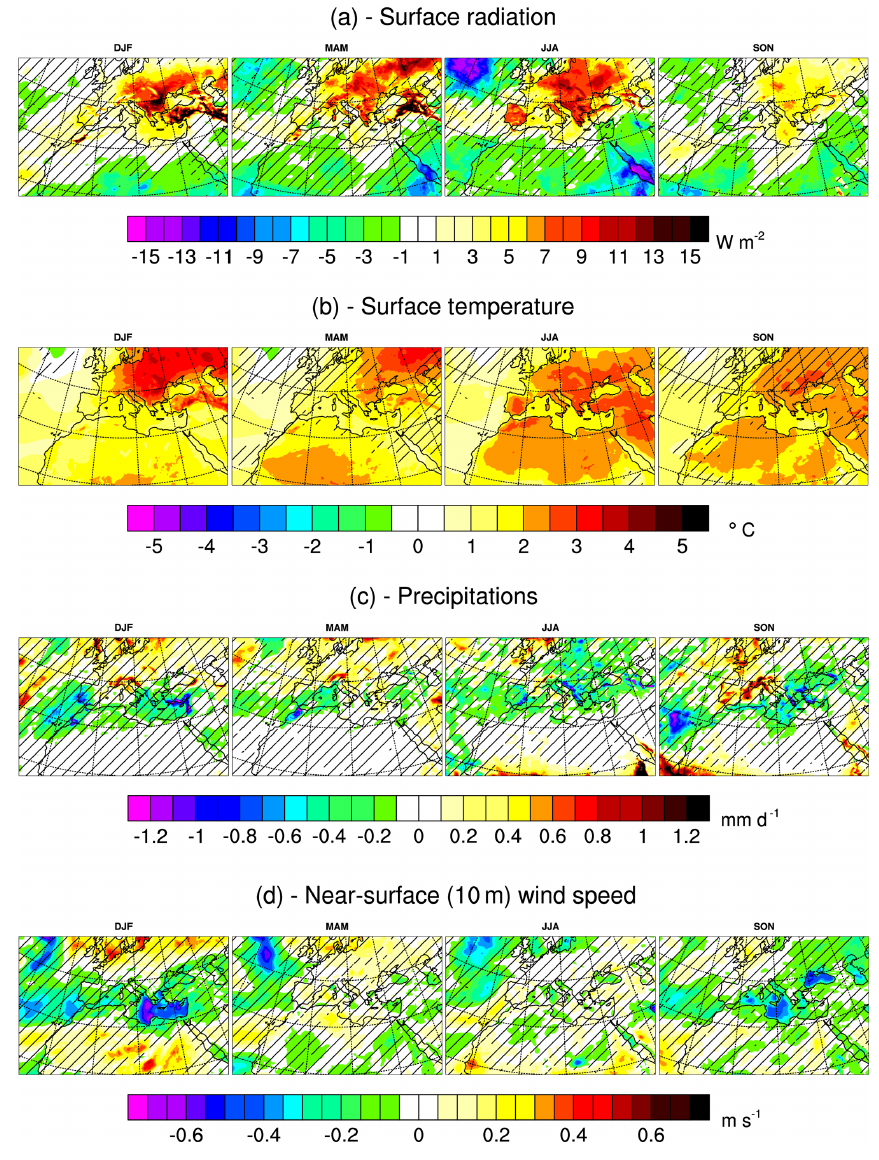
Figure 11. Surface radiation (Wm − 2 , a ), surface temperature ( ◦ C, b ), precipitation (mmd − 1 , c ) and surface wind speed (ms − 1 , d ) evolution between the periods 1971–2000 and 2021–2050 for the SSP 5-8.5. The hatched areas are statically non-significant with a threshold of